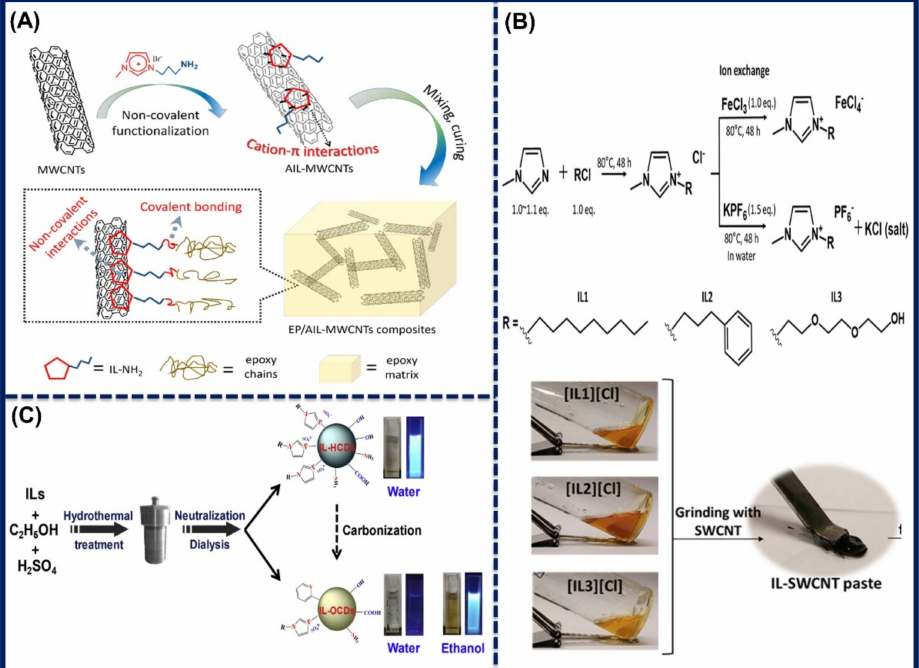
Figure 7. Synthesis of ( A ) EP/AIL-MWCNTs nanocomposites. Reprinted with permission from Ref. [72]. Copyright 2019, Elsevier. ( B ) Methyl imidazole-based ILs with Cl − and anion exchanges from Cl − to FeCl 4 − and PF 6 − for each ILs and ILs-SWCNT pastes. Reprinted with permission from Ref. [73]. Copyright 2018, American Chemical Society. ( C ) ILs-HCDs and ILs-OCDs. Reprinted with permission from Ref. [74]. Copyright 2017,